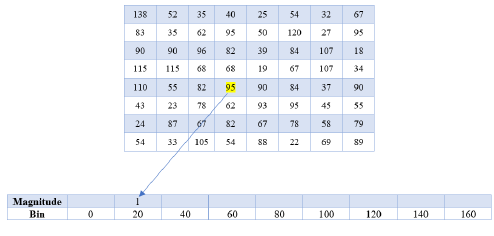
Figure 6. Mapping pixels to